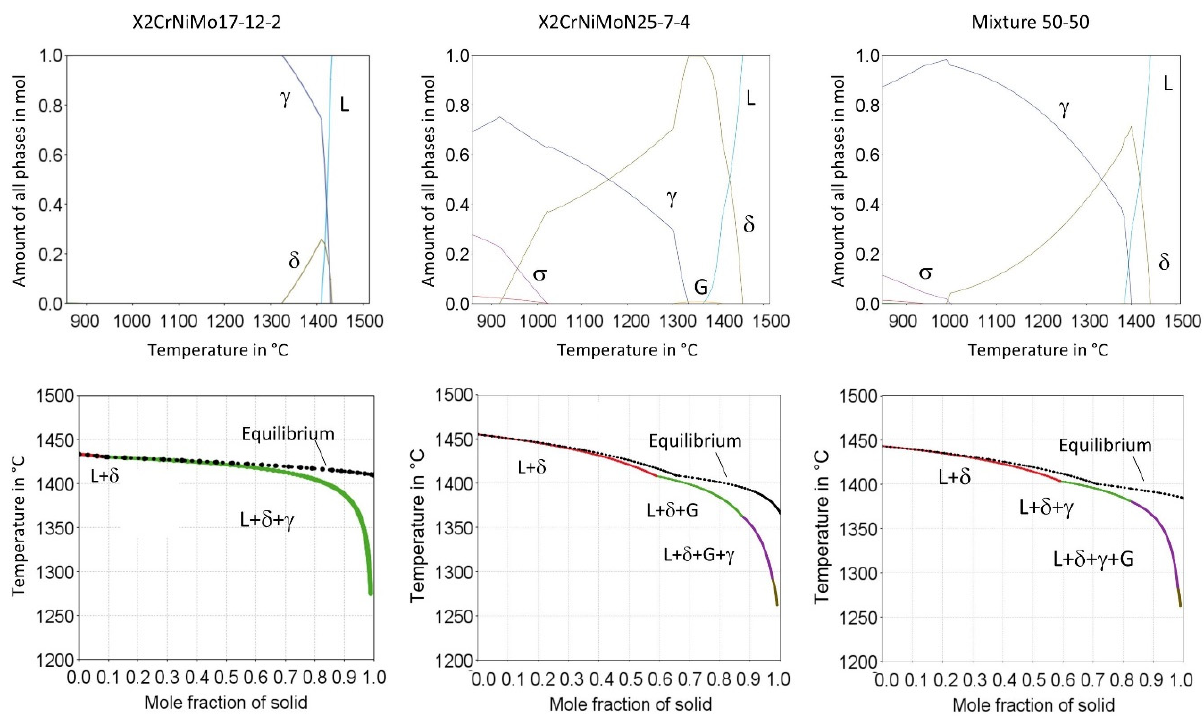
Figure 15. Thermodynamic calculation of the austenitic stainless steel 316L and the duplex stainless